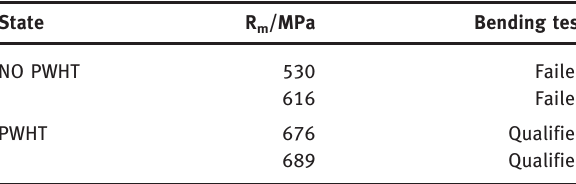
Table 4: Results of the tensile and bending tests of T92/Super 304H dissimilar weld joints with and without post-weld heat treatment